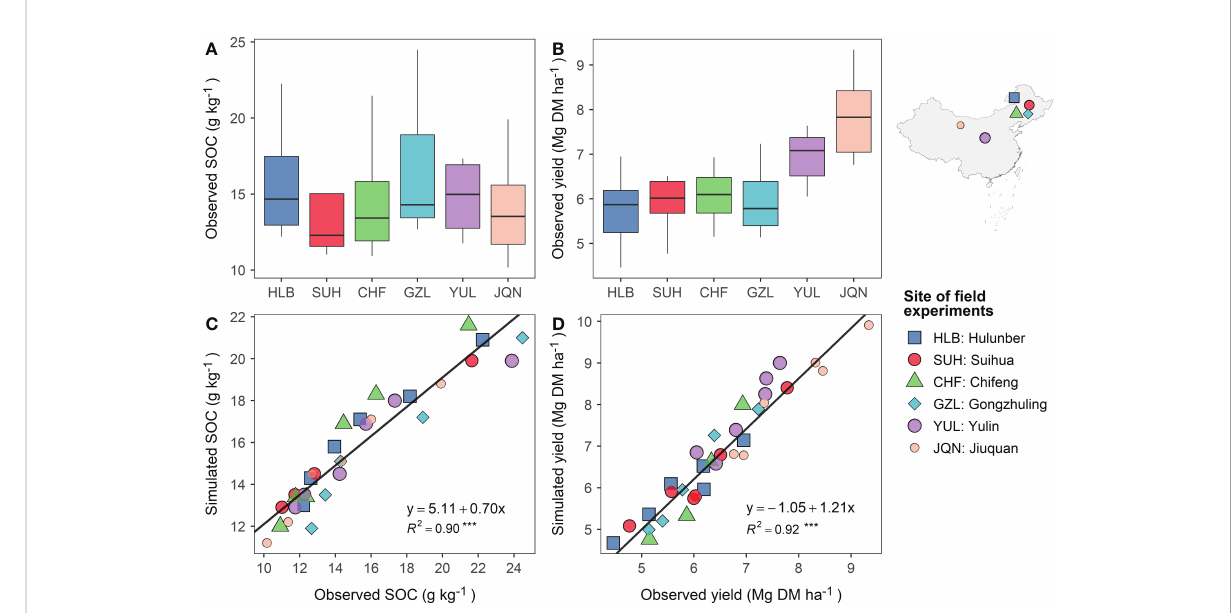
FIGURE 5 Field observed 0-30 cm soil organic carbon (SOC) content (A) and alfalfa aboveground dry-matter yield (B) , and their relationships with the DNDC simulated SOC (C) and yield (D) at six experimental sites across northern China from 2012 to 2017. The solid black line in C and D represents the linear trend fi tted to the simulated versus the observed data. ***p < 0.001.